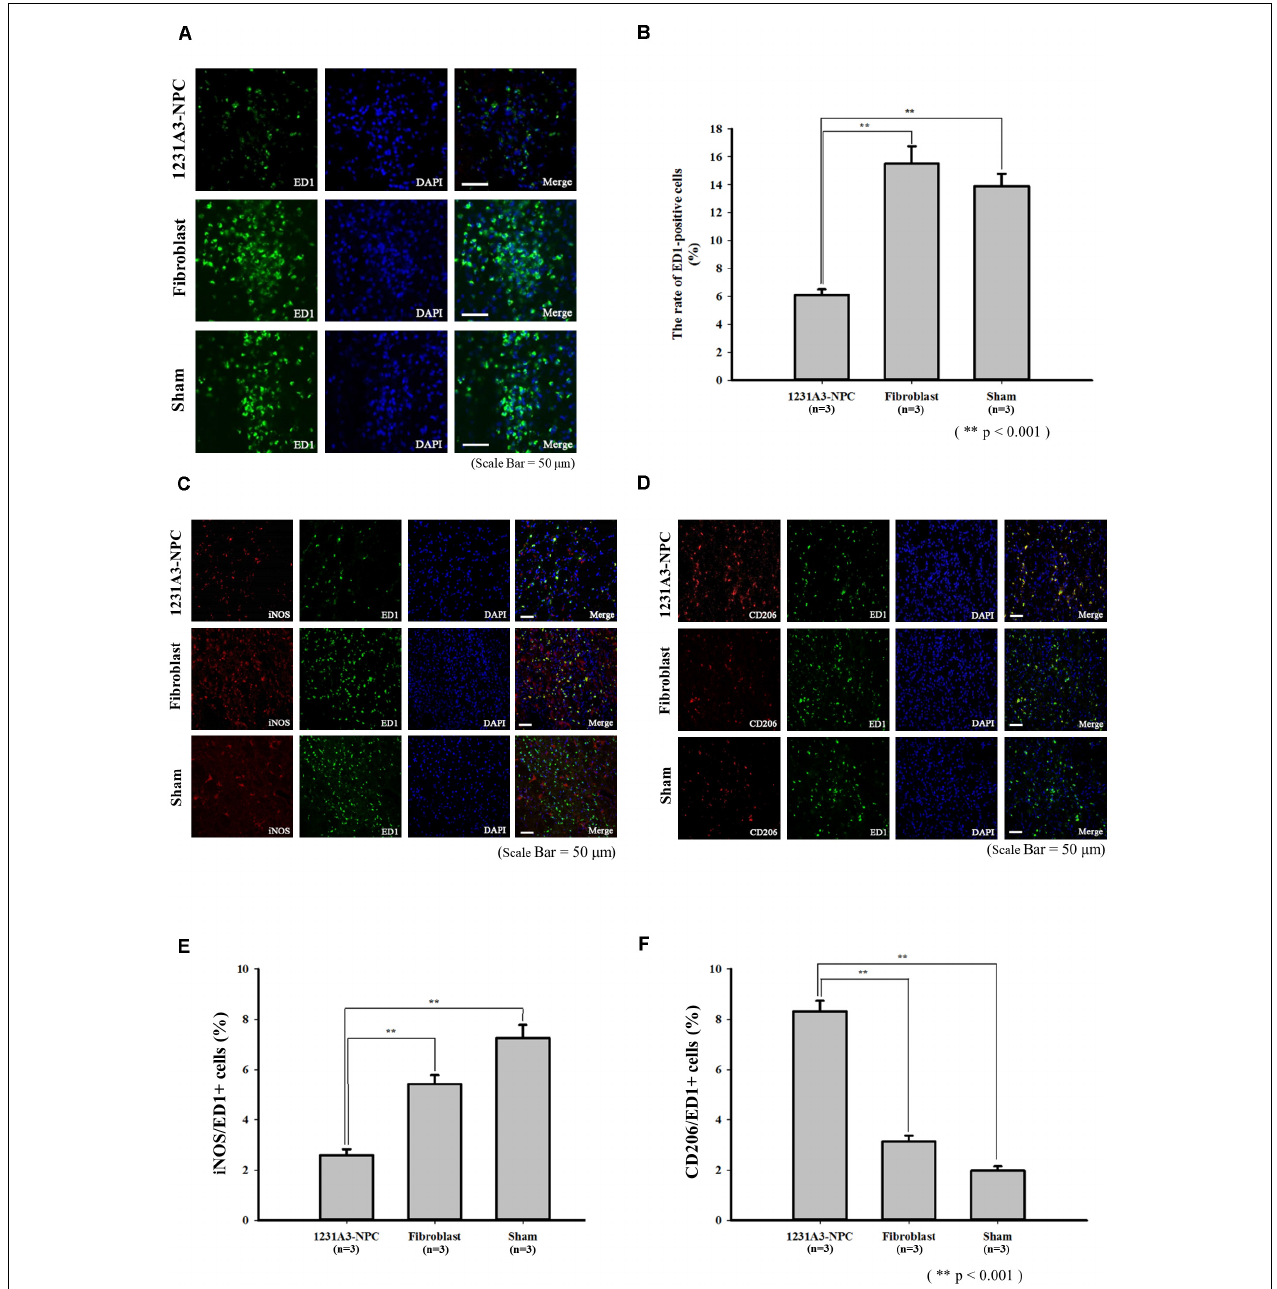
FIGURE 5 | Effects of 1231A3-NPCs on inflammatory responses in QA-lesioned rat model 13 weeks post-TP. (A) Activated microglia marker (ED1) staining. (B) Bar graph showing the number of ED1-positive cells ( n = 3 in each group). (C) Proinflammatory cytokine (iNOS) staining. (D) Anti-inflammatory cytokine (CD206) staining. (E,F) Bar graph showing the rate of iNOS-positive cells and CD206-positive cells ( n = 3 in each group). Scale bar = 50 µ m, ** p < 0.001. NPCs, neural precursor cells; QA, quinolinic acid; TP,